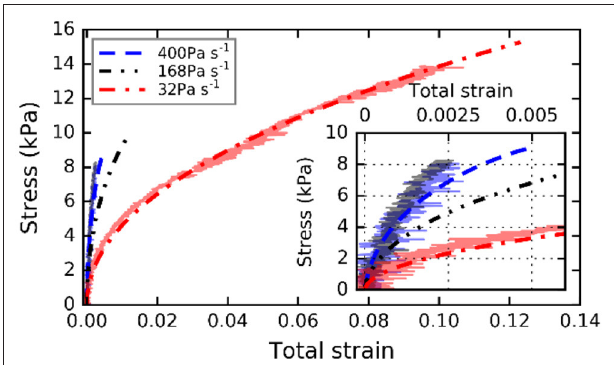
FIGURE 9 | FBM and experimental results for load-controlled conditions. The dotted line indicates the FBM results. Reprinted from [55].